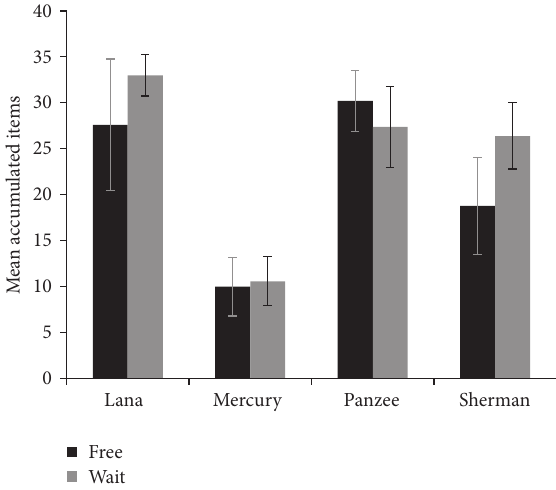
F 2: Accumulation performance as a function of whether the partner received free rewards during the delay interval (free condition) or passively waited to receive those items at the end of the test session (wait condition). Error bars represent the Standard Error of the